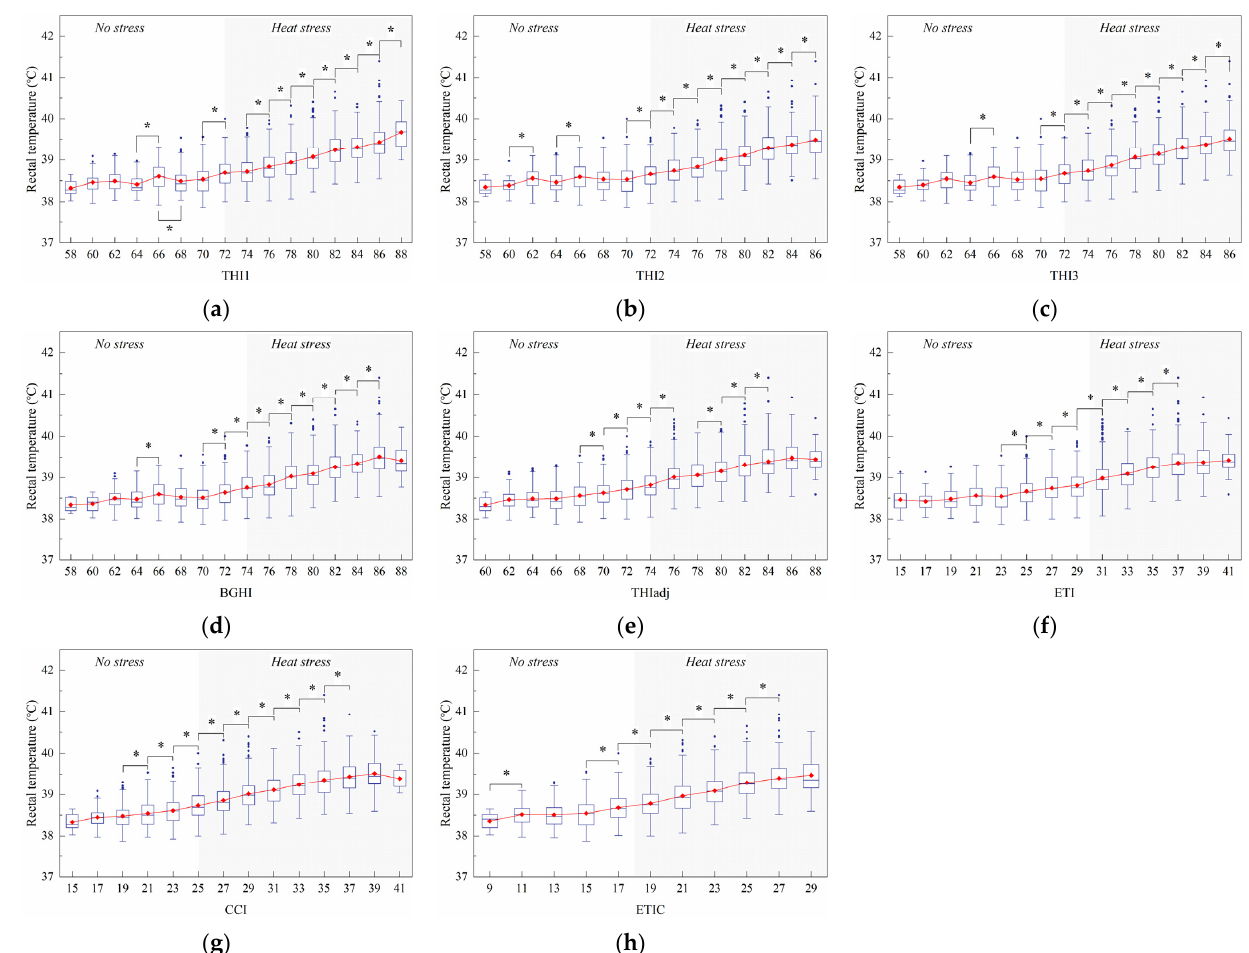
Figure 6. Effect of the thermal index values on rectal temperature. The interquartile range (IQR) is shown by a blue box, the median as a blue horizontal line, the mean as a red square, and the whiskers extend to 1.5 IQR. Outliers are indicated by blue dots. An asterisk indicates a significant ( p < 0.05) change in the variable. The thermal indices are the temperature–humidity index (THI1 ( a ), THI2 ( b ), THI3 ( c )), black globe humidity index (BGHI ( d )), adjusted THI (THIadj ( e )), equivalent temperature index (ETI ( f )), comprehensive climate index (CCI ( g )), and equivalent temperature index for dairy cattle (ETIC ( h )).